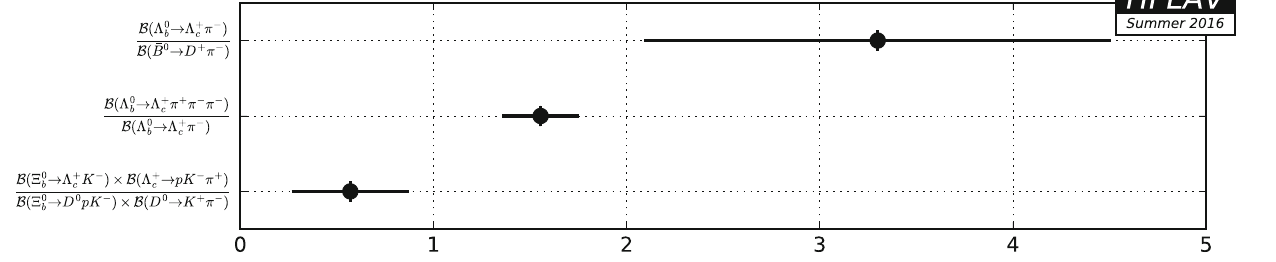
Fig. 173 Summary of the averages from Table 214